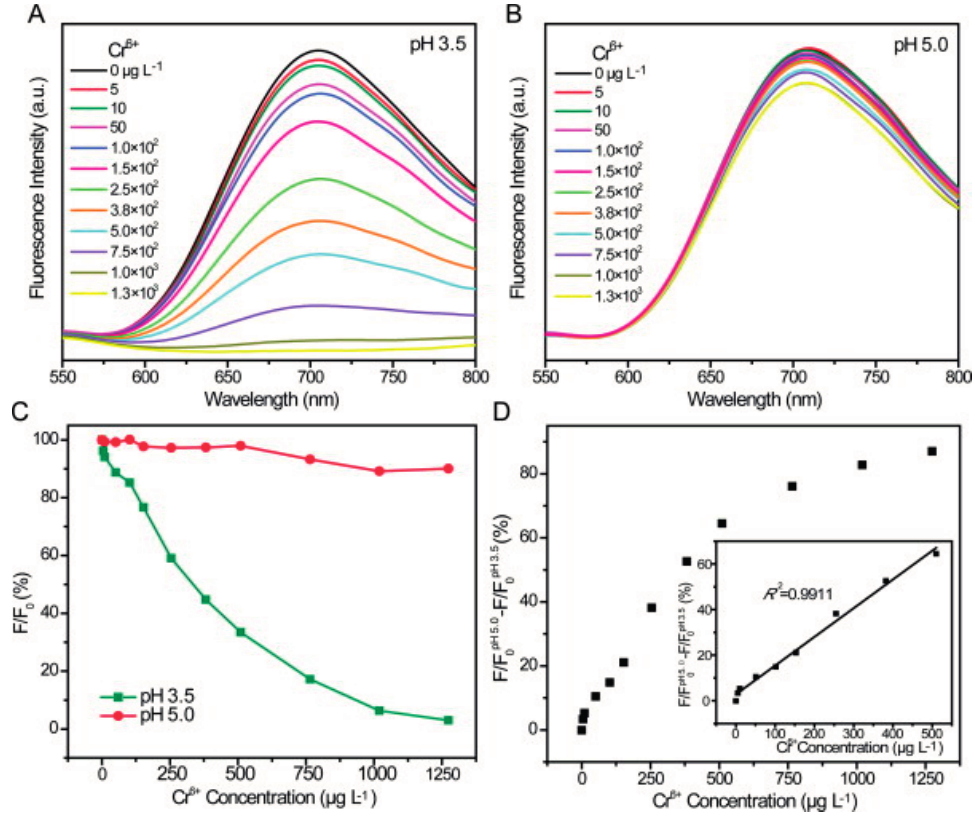
Figure 8. ( A ) Effect of Cr(VI) concentration on fluorescence of GSH-AuNCs (pH = 3.5) and ( B ) pH = 5.0 ( C ) Relative fluorescence of GSH-AuNCs with increasing Cr(VI) concentration ( D ) Difference in relative fluorescence between pH = 3.5 and pH = 5.0 solutions with increasing Cr(VI) concentration [162]. Reprinted from [162], with permission from